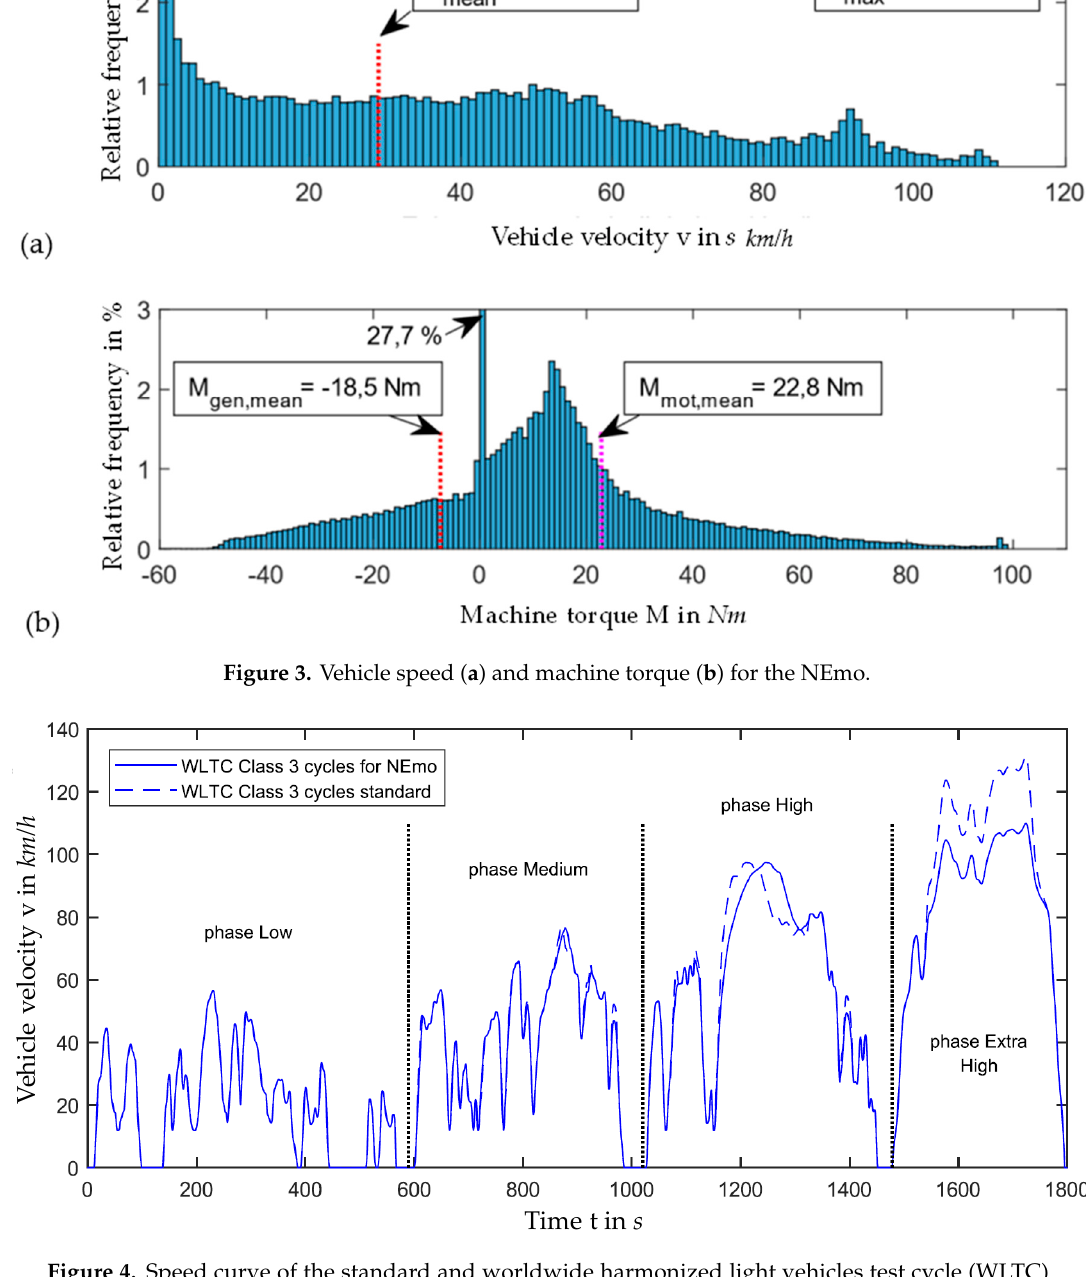
Figure 5. Machine winding overhang temperature for the NEmo. The coolant of the electric machine reaches a maximum temperature of 45 °C and has an average temperature of 23 °C. The coolant is fed to the electric machine at a maximum temperature of 45 °C. The frequency distribution is shown in Figure 6. It should be noted that the temperature sensors are positioned in the cooling hoses and not directly at the outlet of the electric machine. If the coolant pump is switched off, they measure the ambient temperature at the start of the journey until the pump is switched on. This results in the shown frequency peaks. The comparison of the coolant pump status with the winding overhang temperature shows that the pump is switched on at a winding head temperature of 33 °C.